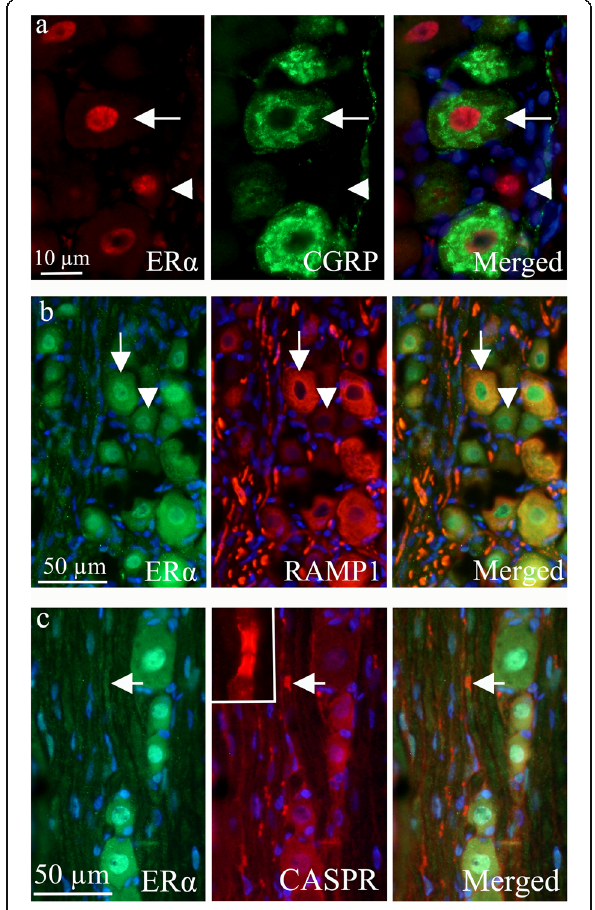
ER α ( P = 0.0196, Fig. 10a), 34% of the male and 72% of the female neurons expressed ER β , ( P = 0.0129, Fig. 10b).